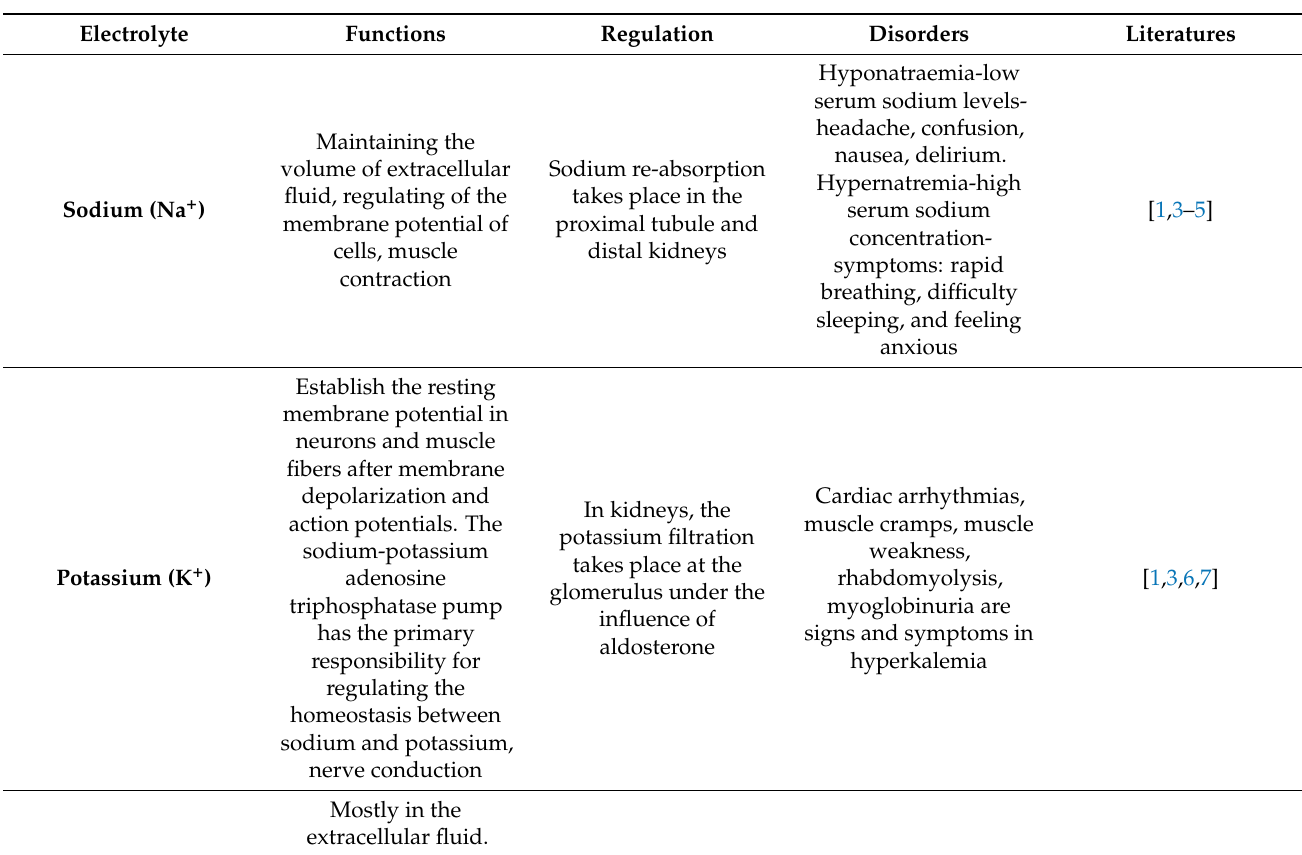
Table 1. The most significant electrolytes in animal